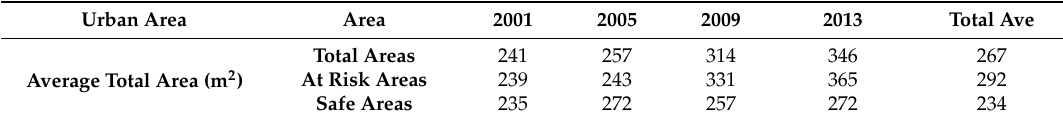
Table 4. The average urban area divided into at risk areas and safe